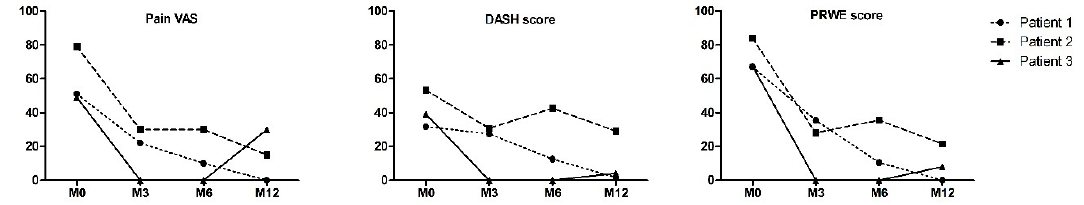
Figure 3. Evolution of pain according to Visual Analog Scale (VAS), Disabilities of the Arm and Shoulder (DASH) and Patient-Rated Wrist Evaluation (PRWE) scores at baseline, and months 3, 6 and 12 for patients 1, 2 and